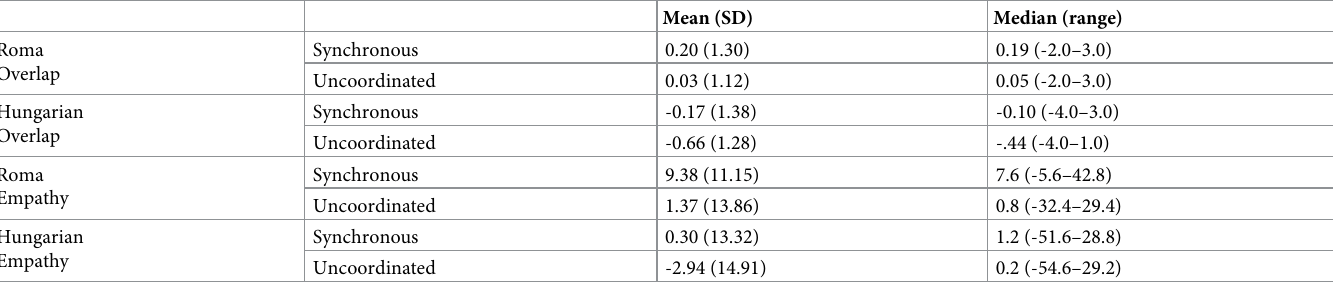
Table 3. Descriptive statistics for the overlap and empathy change scores towards Hungarians and